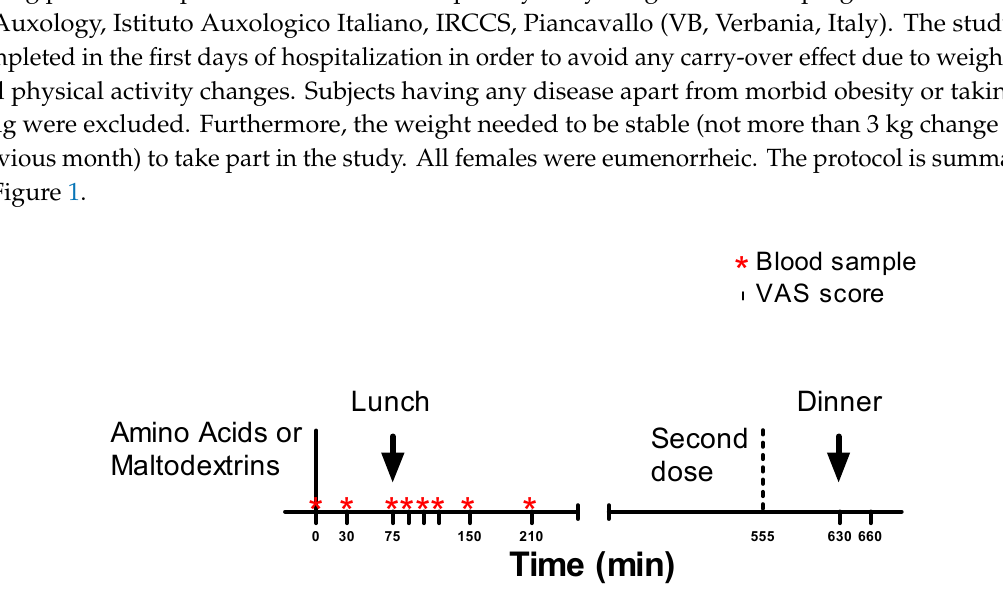
Figure 1. Overview of the experimental protocol. VAS: visual analogue scale.